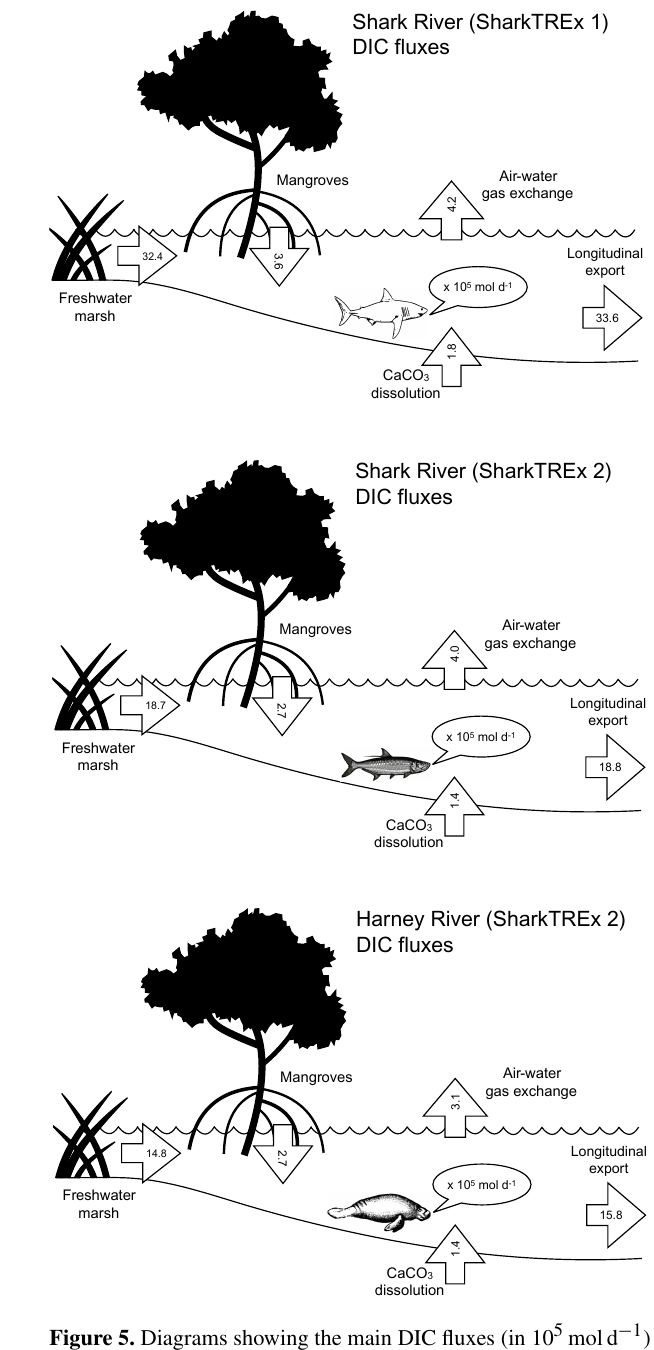
DIC was the dominant form of dissolved carbon in both rivers and accounted for 79 to 82 % of the total dissolved carbon in the rivers. The contribution of DOC to the total carbon pool varied between 18 and 21 % (Table